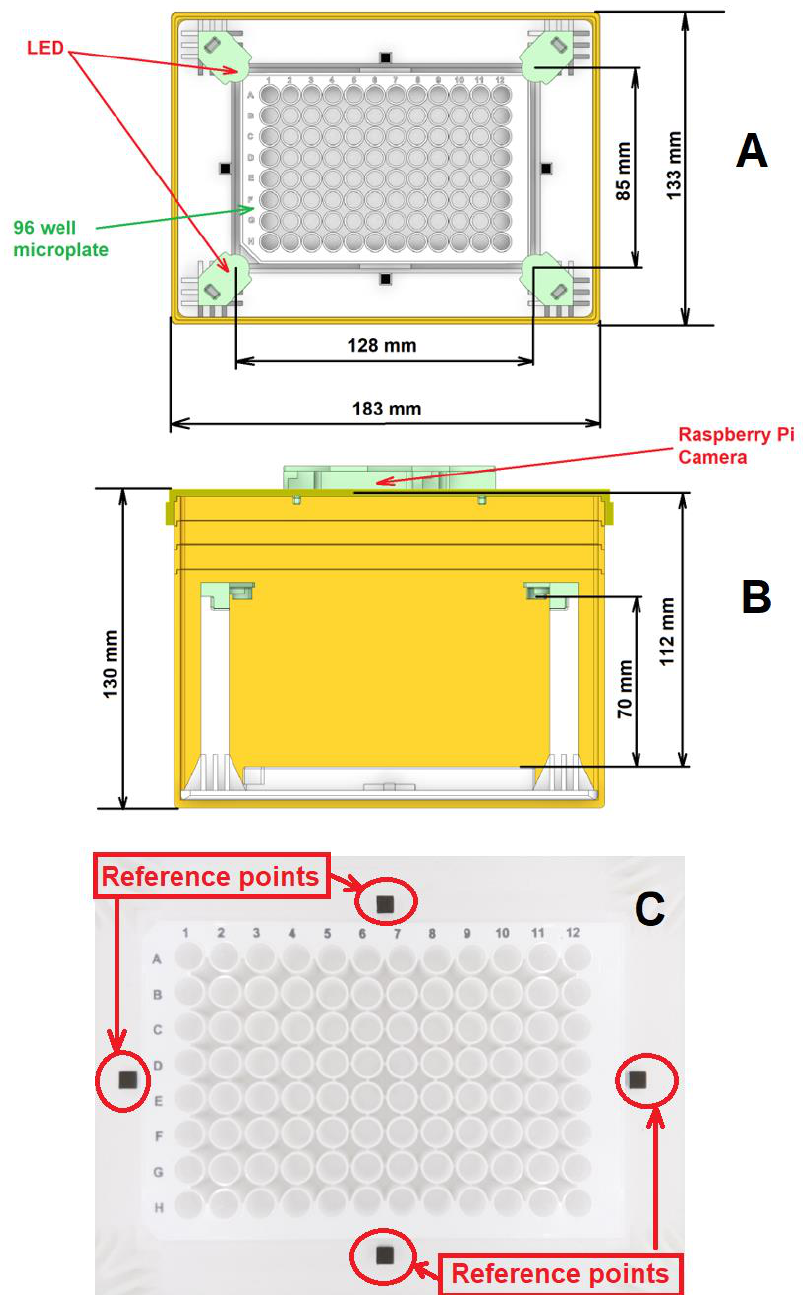
Figure 1. ( A , B ) The sketch of a 96-well microplate colorimetry prototype; and ( C ) a white 96-well microplate image taken by a Raspberry Pi camera in the proposed device (Dark squares are four reference points for image process).